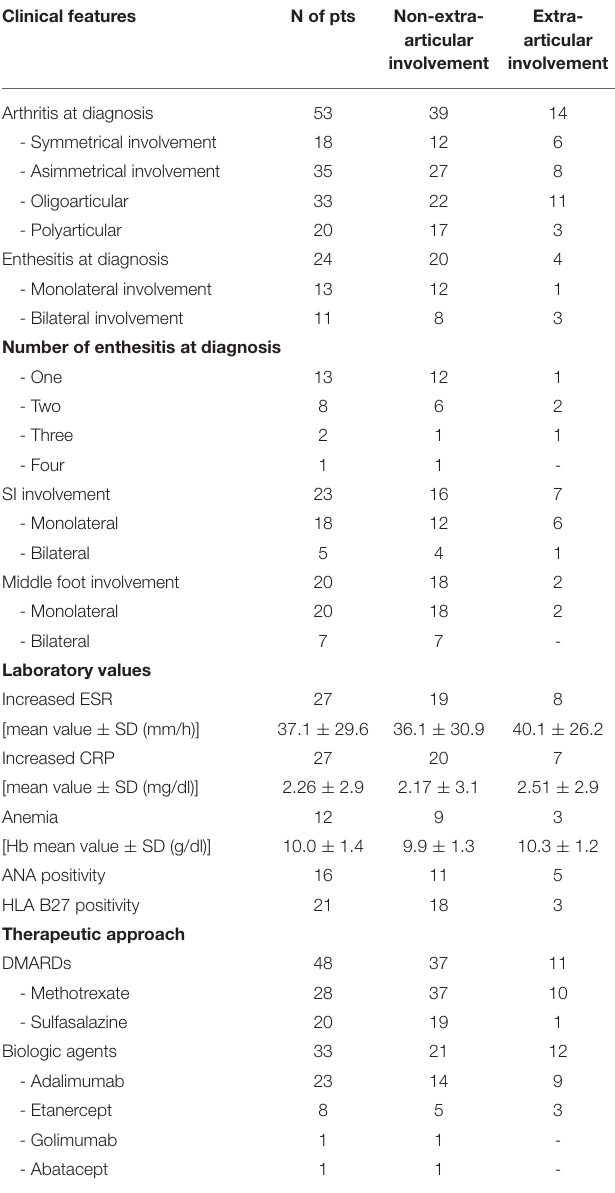
TABLE 1 | Clinical features, laboratory parameters and therapeutic approaches of our cohort of diagnosed as ERA-JIA at the onset of disease. Clinical